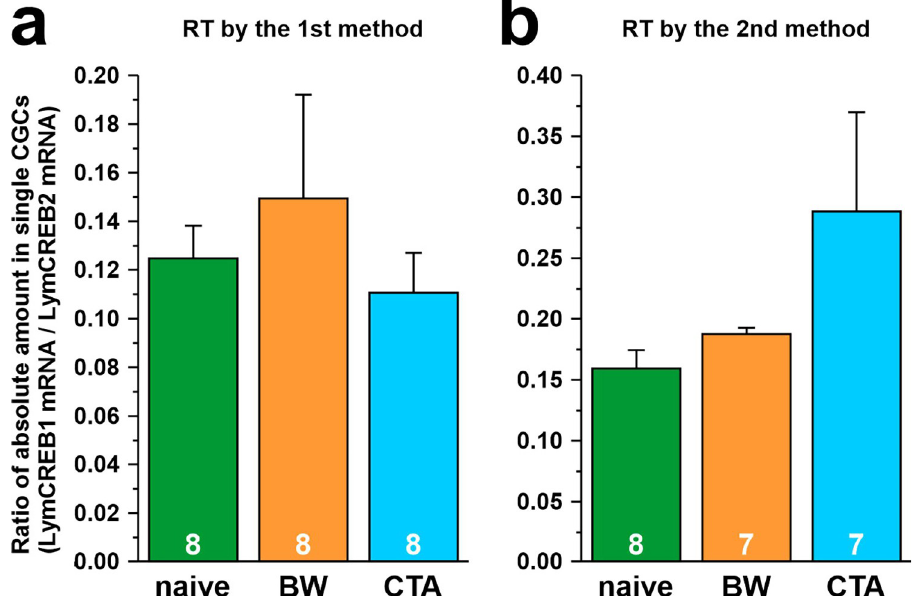
Fig 6. Ratio of LymCREB1 mRNA/LymCREB2 mRNA in a single isolated CGC. The data were obtained by absolute quantification with samples reverse-transcribed by RT method 1 (A) and RT method 2 (B). Green, orange, and blue bars show na ï ve-control, BW-trained, and CTA-trained snails, respectively. Data are expressed as mean ± SEM. p - values of 1-way ANOVA are 0.61 (A) and 0.15 (B). The number of samples is indicated at the bottom of the bar graph.